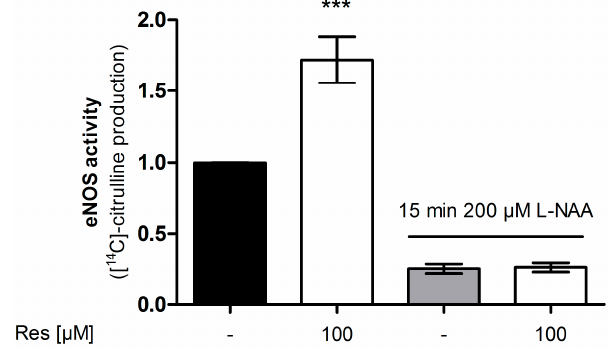
Figure 3. Influence of the NOS inhibitor L -NAA on the effect of resveratrol on eNOS enzyme activity. EA.hy926 cells were treated with the indicated concentrations of resveratrol for 24 h. Then an [ 14 C] L -arginine/[ 14 C] L -citrulline conversion assay was performed as described both in the presence and absence of the NOS inhibitor L -NAA. [ 14 C] L -citrulline production was normalized to the untreated control ( *** p < 0.001; mean ± SD, n =